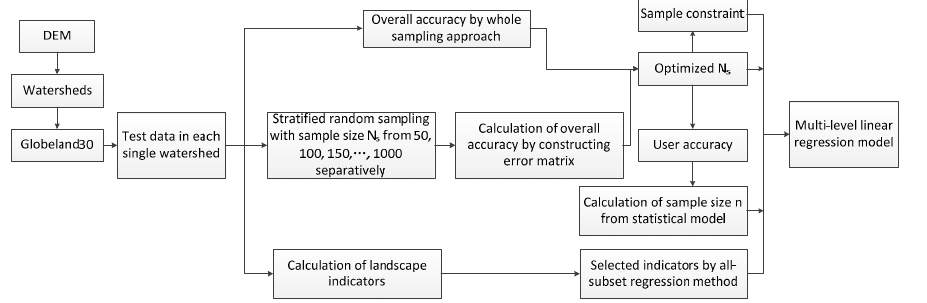
Figure 4. Procedures of parameter determination used in a multi-level linear regression method.